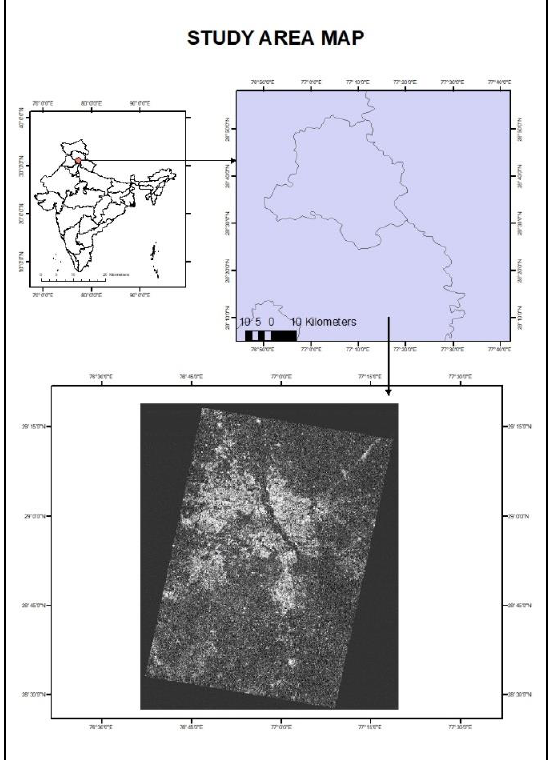
Figure 1 Study area map of Delhi and NCR region of